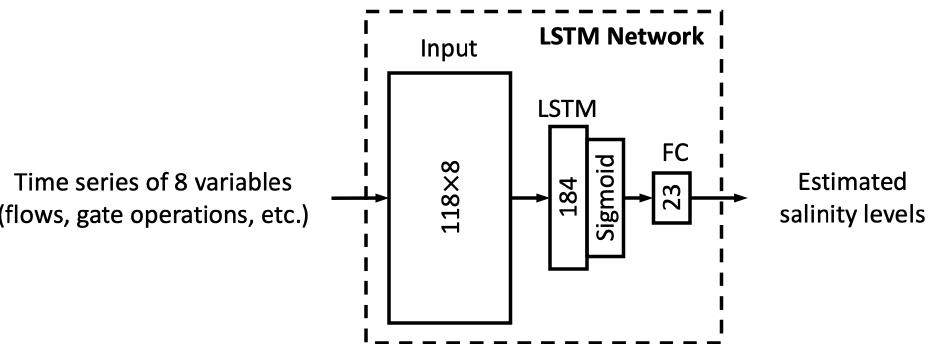
Figure A3. Diagram of the LSTM network from [29]. The number in the input layer denotes input shape and those in the subsequent layers represent the numbers of units/neurons of the layers.